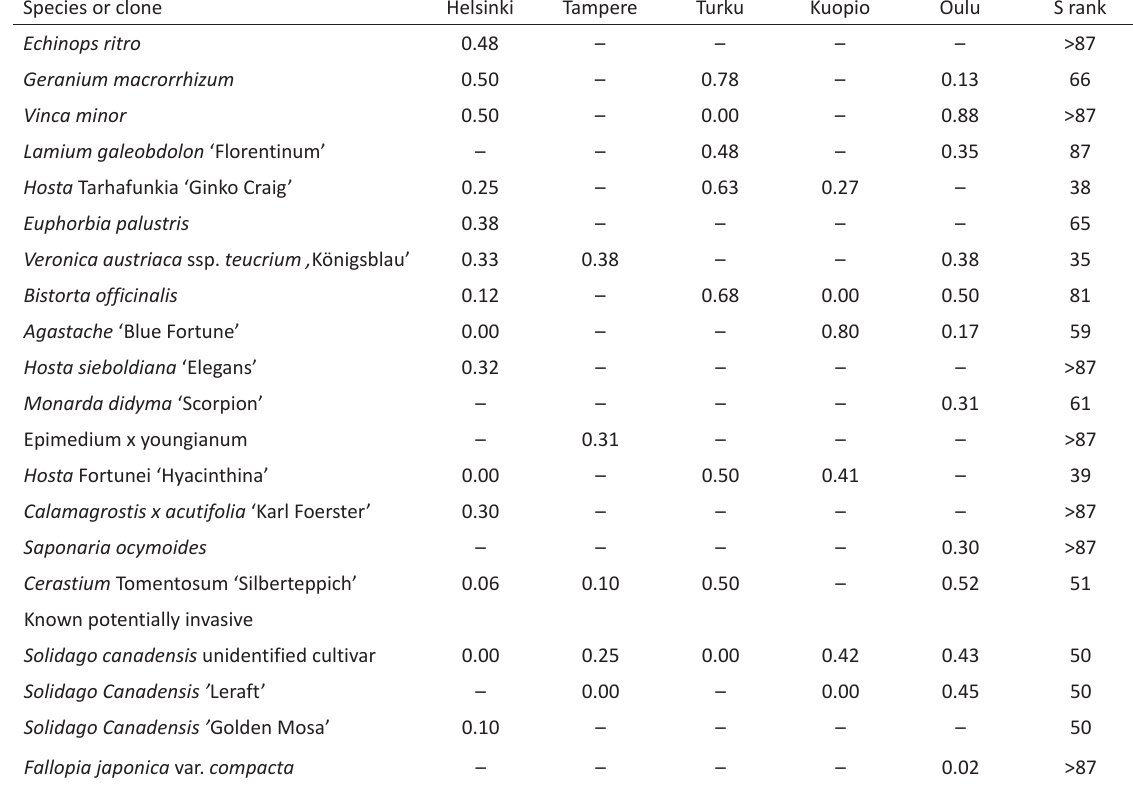
Table 4. Mean rhizome production in common garden experiments in 2006–2010. In the righthand column, the S rank is the mean of common garden maximum ranks of seedling emergence. Means were calculated over cities. Fifteen clones ranked highest by rhizome production or having a mean score higher than 0.5 in any garden are shown. Below are also results for other clones that are considered potentially invasive ( MMM 2012 ). Clones are sorted by mean rank of rhizome production over cities. Cities where clones were not tested are marked by